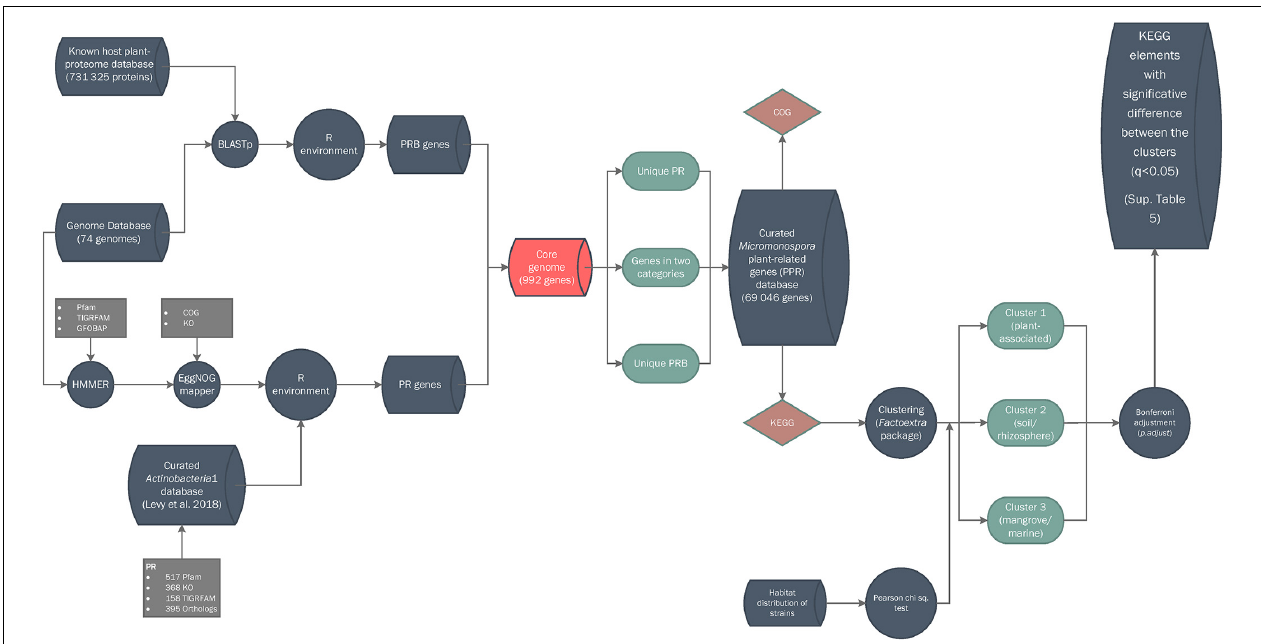
FIGURE 1 | Bioinformatic workflow for database construction. Symbols: cylinders, databases; circles, pipeline processes; rhomboids, annotations; squares, input data; balloons, partial results.